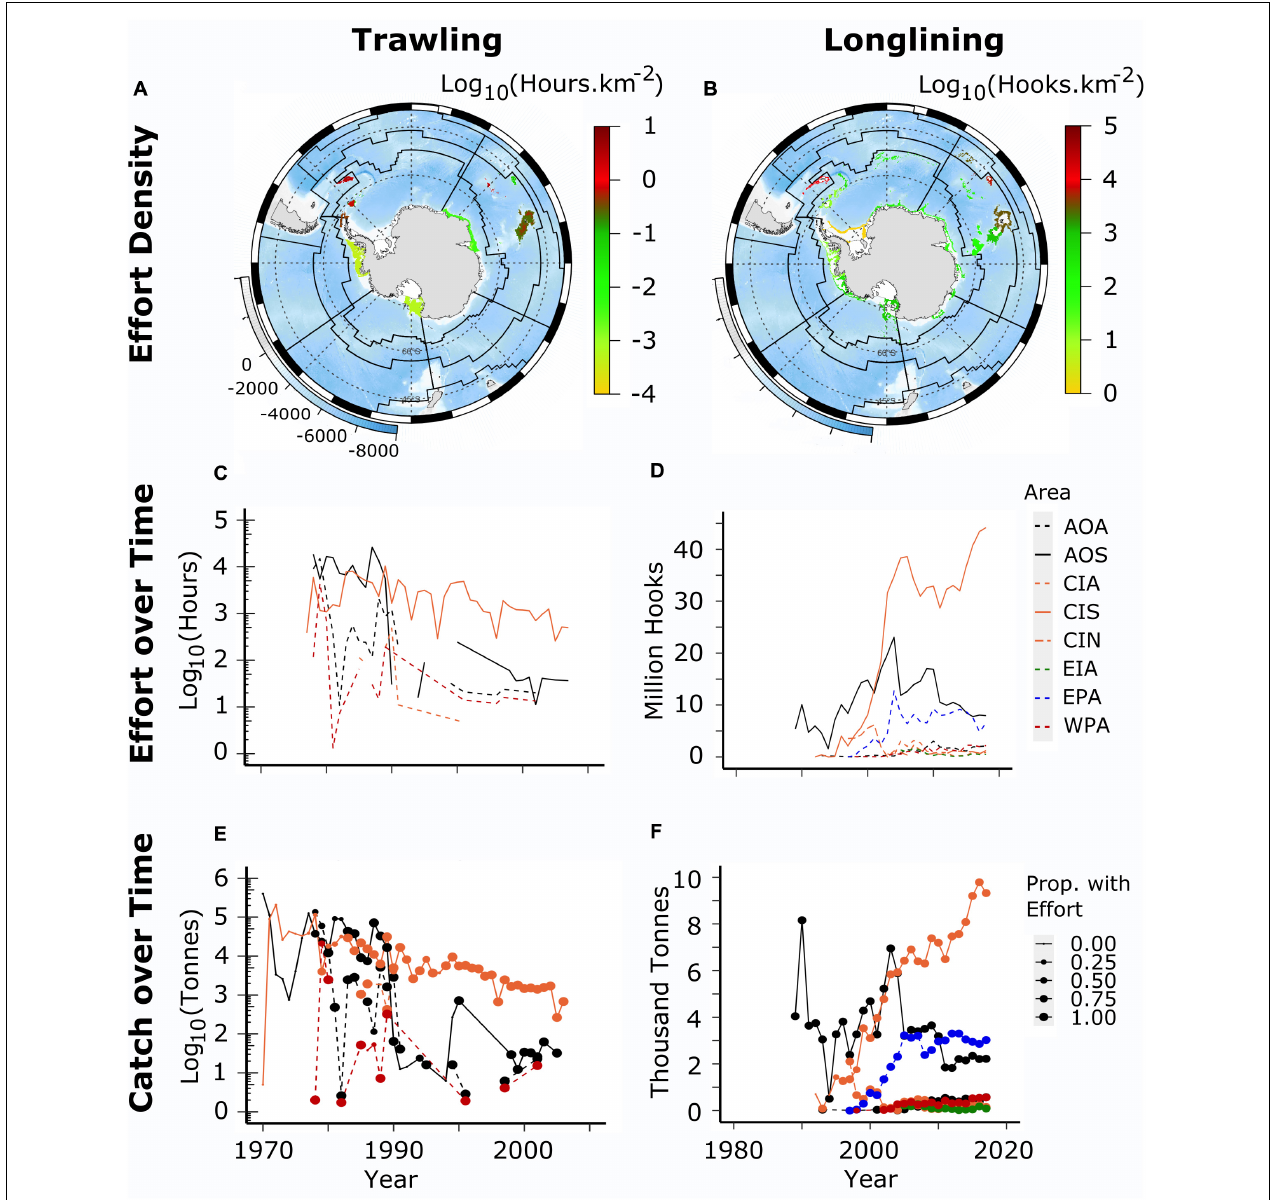
FIGURE 12 | Bottom fishing effort in MEASO areas for trawl and longline fisheries. Top row (A,B) shows effort density per km 2 – hours and hooks, respectively, on a log10 scale. Background is ocean depth (bottom left legend on each map). Black lines show boundaries of MEASO areas as depicted in Figure 2 . Middle row (C,D) shows effort over time (split year) in each MEASO area according to the legend at right where labels indicate the sectors (first two letters) and zones (last letter) for each area. Sectors are Atlantic (AO), Central Indian (CI), East Indian (EI), West Pacific (WP), and East Pacific (EA). Zones are Antarctic (A), Subantarctic (S), and Northern (N). Bottom row (E,F) shows the time series of catches in each area – colour and line types according to the middle row legend. Catches are the total catch of targeted species in bottom fisheries (groundfish, icefish, and toothfish). Circle size indicates the proportion of the catch that had effort data associated with